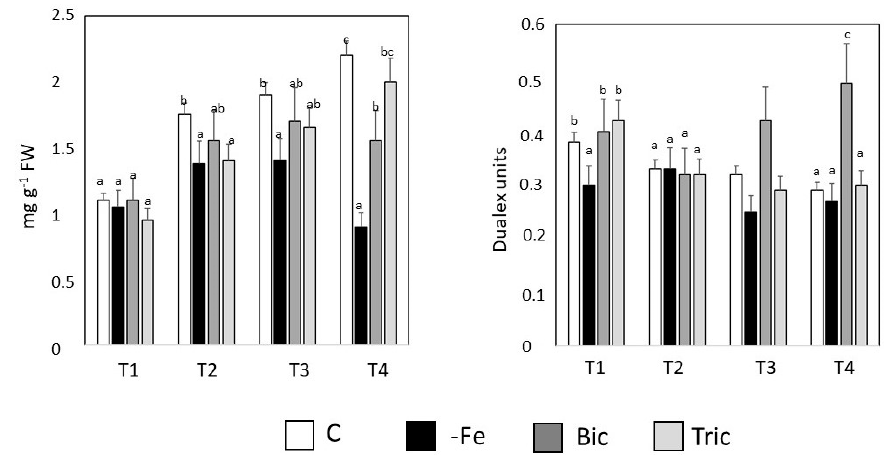
Figure 2. Leaf chlorophyll contents (mg g − 1 FW) (left panel) and total flavonoid contents (expressed in Dualex units) (right panel) in leaves of plants grown in control conditions (C), direct iron deficiency (–Fe), and under induced Fe deficiency in the presence of bicarbonate (Bic) or alkaline organic buffer (Tric). T1, T2, T3, and T4 correspond to sampling at 1, 3, 5, and 7 days. Error bars represent the means ± SE (standard error) ( n = 5). Different letters indicate statistical differences ( p < 0.05) within each treatment.